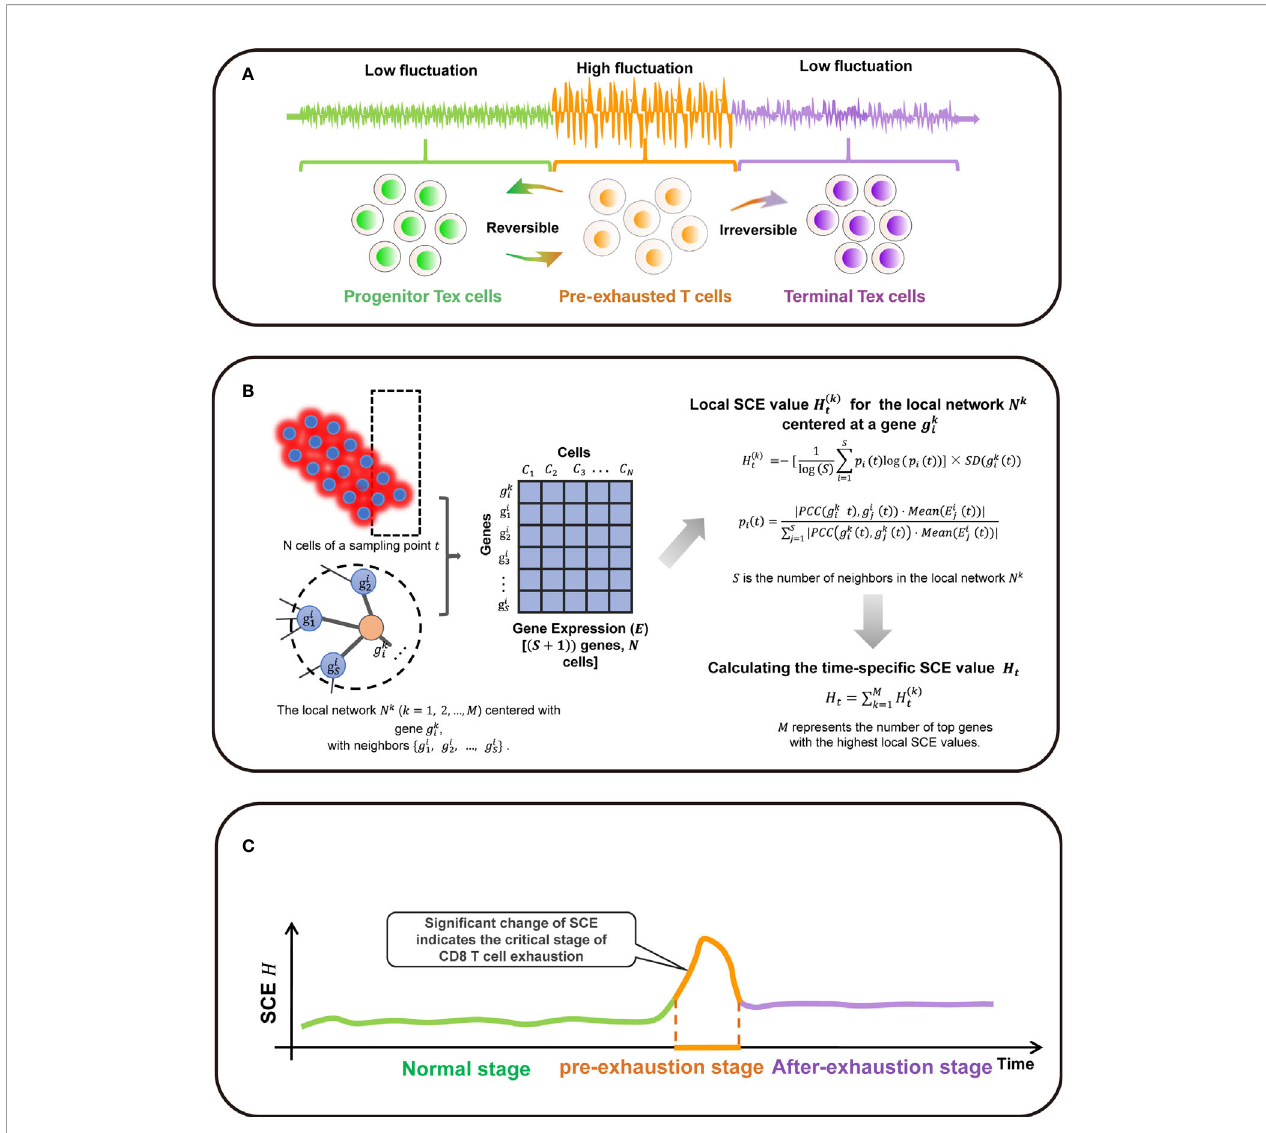
FIGURE 1 | Overall project design together with algorithm details. (A) The three stages transition of PPI network during T cell exhaustion progression in classic dynamic network biomarker theory. (B) Single-cell sample-based node entropy algorithm. (C) A spike of the SNE curve exists in T cell exhaustion